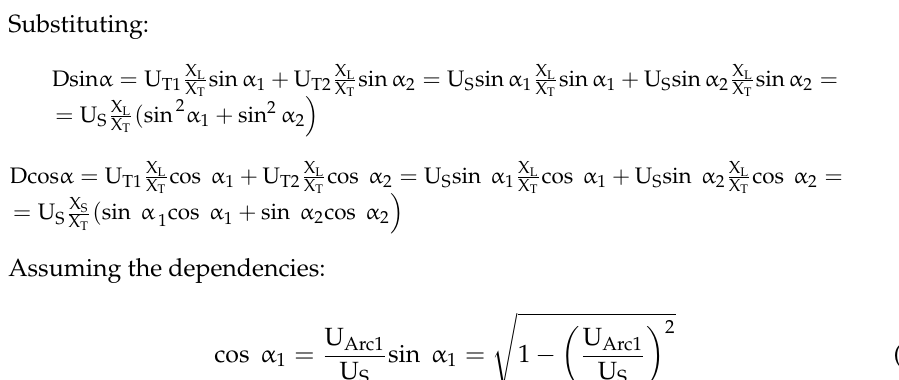
Figure 12. Vector diagram of the currents and voltages of the arc